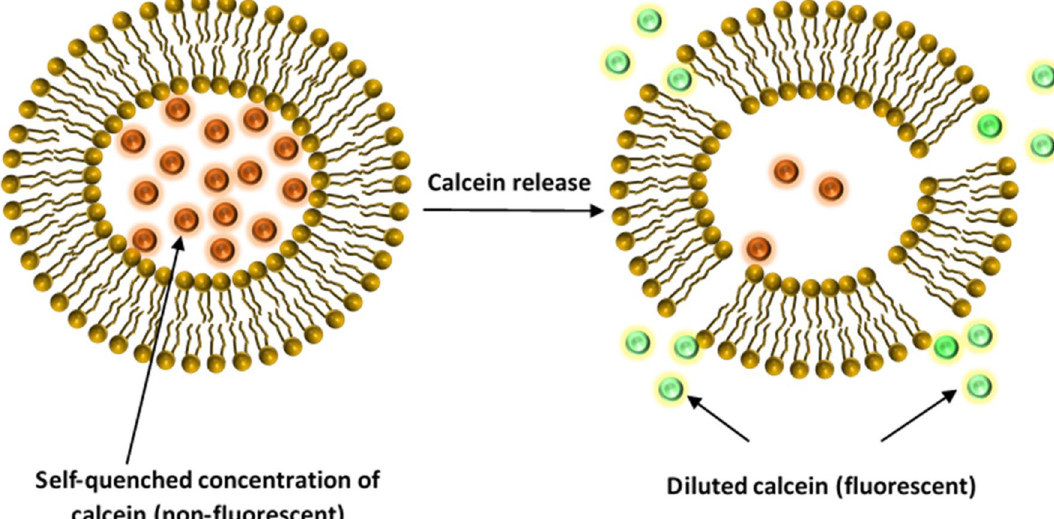
Figure 10. Schematic representation of liposomes encapsulating calcein at a self-quenched concentration. Calcein becomes fluorescent when released and diluted in the aqueous Tf receptors present on the surface of the cervical cancer cell line (the HeLa cell line) to supply the high demand for iron. Following the binding of Tf-PEG liposomes to the receptors, low-frequency ultrasound (LFUS) was applied to enhance the release of the encapsulated calcein in a spatiotemporally controlled manner. While the LFUS sonicating probe was used in this study to show that LFUS triggered calcein release from different liposomal formulations, all other experiments involving cells were conducted using a 35-kHz sonicating bath. Calcein is a self-quenching fluorescent dye. This phenomenon is utilized to investigate the cellular uptake of both liposomes and the fluorescent dye/model drug. Calcein is encapsulated in the inner compartment of the liposomes at a high (self-quenched) concentration. Thus, calcein exhibits very low fluorescence inside the liposomes. High levels of fluorescence, measured via flow cytometry, are due to the release (leakage) of calcein from liposomes and the subsequent dilution in the exterior aqueous surroundings. This occurs when liposomes are taken up by the cells and their contents released, which is then diluted in the cytoplasm allowing its fluores- cence to be detected at a higher level (Fig. 10). Therefore, the flow cytometry detection of calcein inside the cells is correlated to the amount of liposomes taken up by the cells. Low calcein fluorescence inside the cells indicates that a small amount of liposomes and dye are present inside and vice versa. Calcein encapsulation inside the liposomes was already shown to improve calcein uptake by the cancer cells 55 . In our present study, we compared the uptake of calcein encapsulated inside conventional liposomes (non-targeted) compared to targeted liposomes (Tf-liposomes) with and without US triggering. It is expected that targeted liposomes will be taken up more by the cells compared to the non-targeted liposomes due to the added benefit of binding and receptor-mediated endocytosis. This means that more of the encapsulated calcein is taken up by the cells and thus, higher calcein fluorescence intensity will be detected inside the cells treated with targeted liposomes compared to those treated with non-targeted liposomes as was shown in previous studies 56–59 . Sonication with LFUS will trigger calcein release from the liposomes by creating transient pores in the liposomes’ phospholipid bilayer. Also, the sonoporation effect on the cellular membranes allows higher uptake of the liposomes. The third mechanism at play entails liposomes releasing their contents outside the cells and the drug diffusing through their cell membrane due to sonoporation. Therefore, it is expected that US triggering will further increase the amount of calcein detected inside the cells due to these three mechanisms. The size of the synthesized control and Tf-PEG liposomes was within the recommended size of nanoparticles used in drug delivery (< 200 nm). This allows the liposomes to extravasate through the pores formed in the leaky tumor vasculature, also known as the enhanced permeability and retention effect (EPR). Both types of liposomes showed good percentages of polydispersity and showed similar stability when incubated at the biological tem- perature (i.e., 37 °C) for 24 h in terms of maintaining their size and retaining the loaded calcein. We investigated the effect of pulsed LFUS (20 s on, 10 s off) in triggering the release from both the control and Tf-PEG liposomes. While the frequency and pulse duration were kept constant, calcein release, using three different power densi- ties, was compared. Generally, calcein release increased with the increase in power density and the release was detected during the “on” pulse period but froze during the “off” period. This indicates that LFUS was the main trigger of calcein release rather than other factors such as lipid oxidation. Previous studies have also shown that US triggers drug release from liposomes in a controlled manner 28,37,60 .